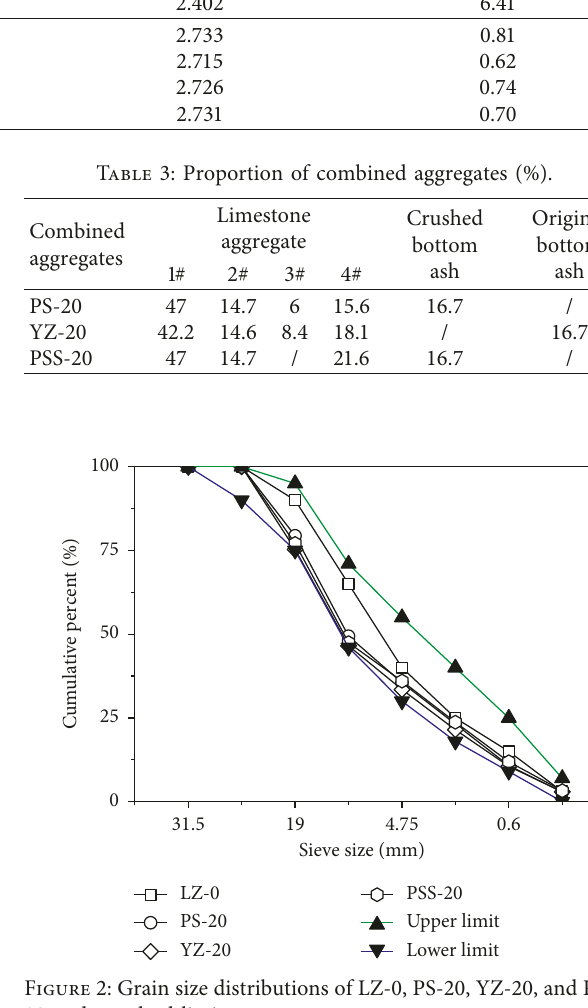
Figure 2: Grain size distributions of LZ-0, PS-20, YZ-20, and PSS- 20 and standard